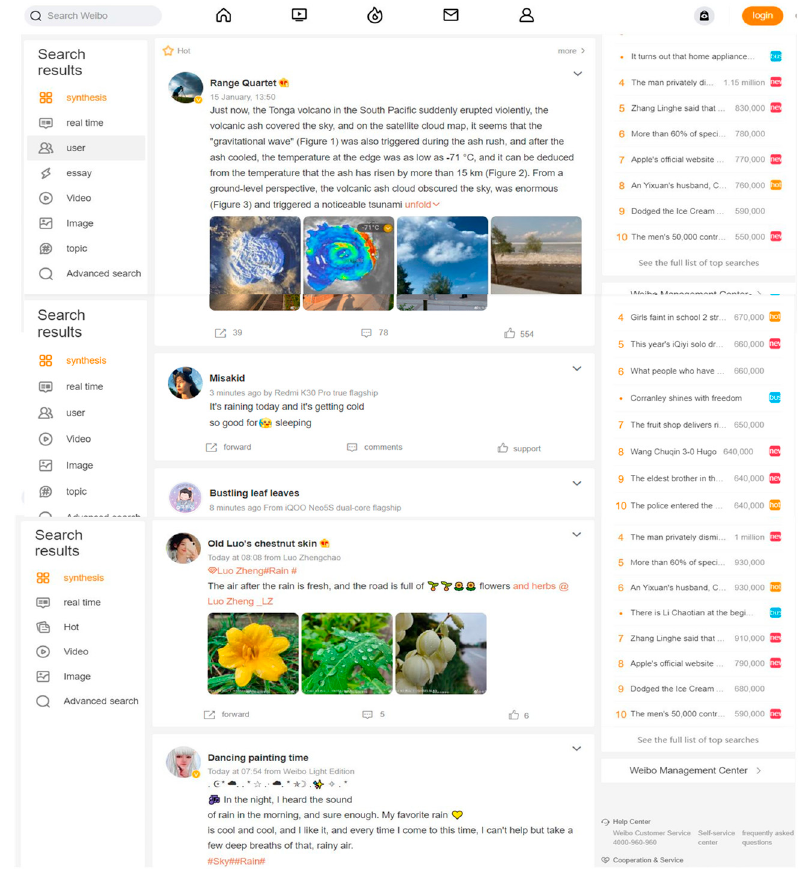
Figure 1. Unstructured data about the contingencies on Weibo.